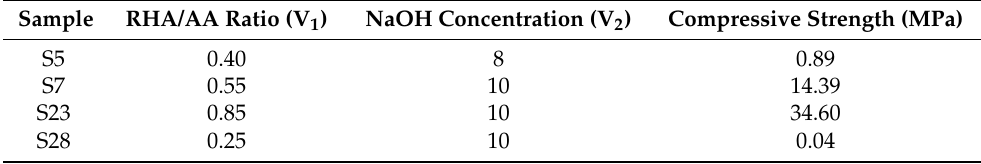
Table 9. Experimental validation for the compressive